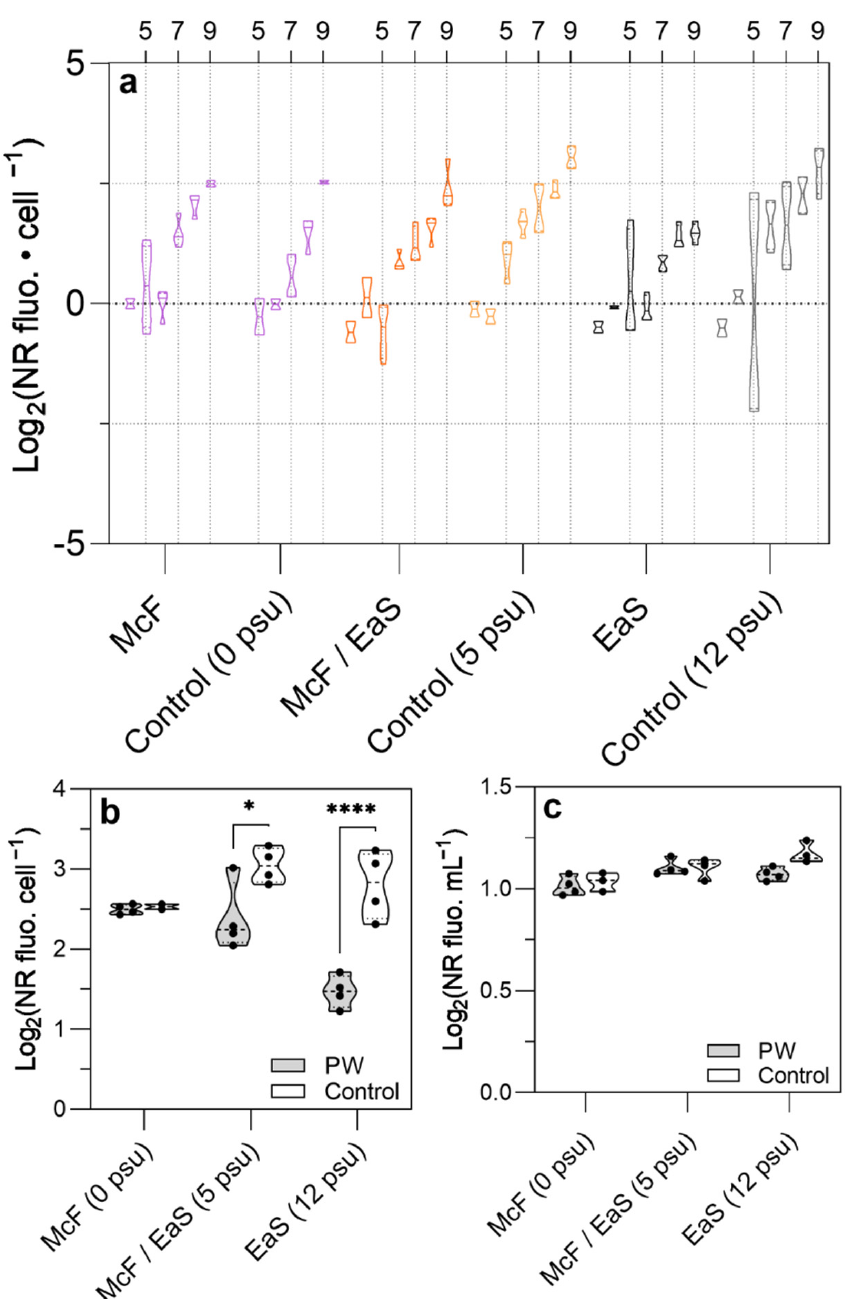
Figure 3. Comparison of Nile Red (NR) based estimation of cellular neutral lipid content in PW media. ( a ) Truncated violin plot showing the frequency distribution of the log 2 -normalized NR fluorescence per cell. The medians are represented by a full line and the quartiles are represented by dashed lines. These measurements were made during cultivation in the three PW media and their respective controls ( n = 4). ( b , c ) Truncated violin plot of the log 2 -normalized NR fluorescence per cell ( b ) and per mL of culture ( c ) on day 9 in the PW media and their controls. Individual data points are shown as dots, the median is represented by a dashed line, and quartiles are represented by dotted lines. The starred comparison marks indicate significant differences based on a two-way ANOVA with post hoc multiple comparisons between the PW treatments and their controls (* adj. p < 0.05; **** adj. p < 0.0001). 3.4. Characterization of the EaS-PW Medium after P. tricornutum Cultivation